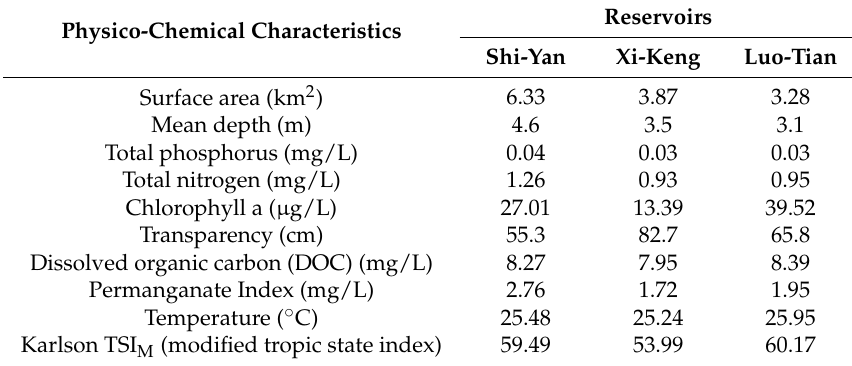
Table 1. Annual physico-chemical characteristics of the three study